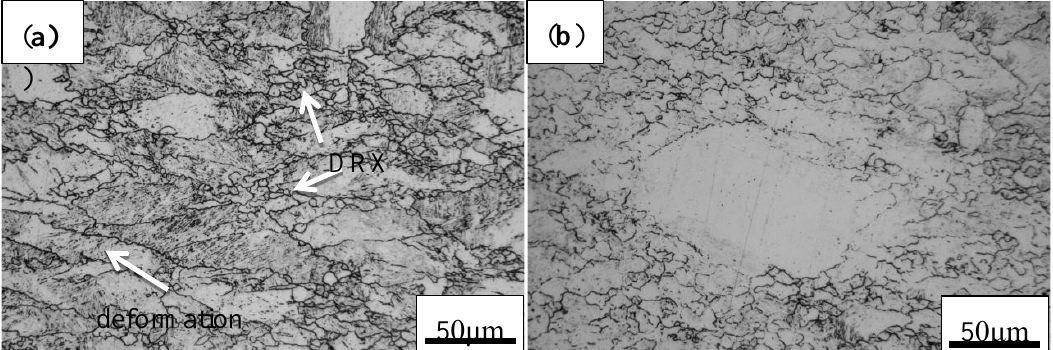
Figure 13. LM micrographs of the examined steel under deformation conditions of ( a ) 1000 °C and 0.005 s − 1 and ( b ) 1050 °C and 10 s − 1 .